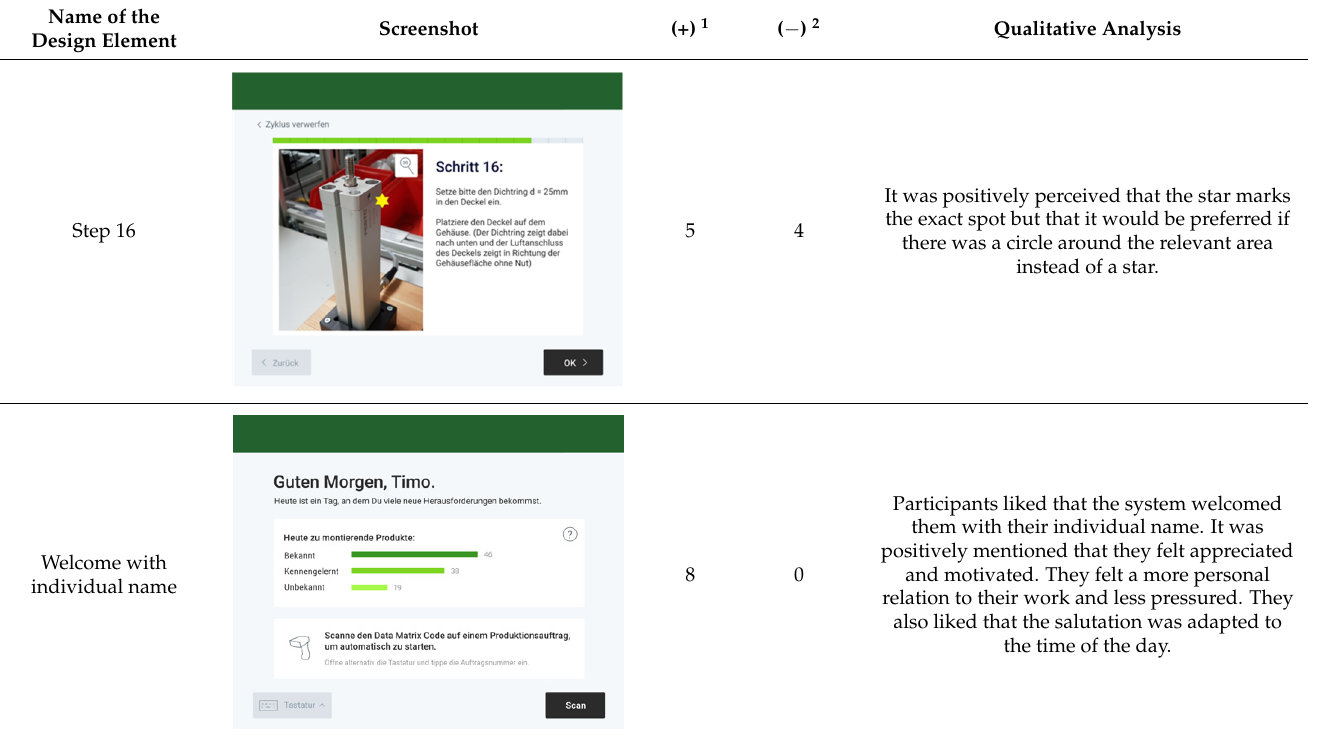
Table A1. Results of qualitative analysis of design elements in WGS prototype that received 6 or more markers and are not part of positive UX design concepts.